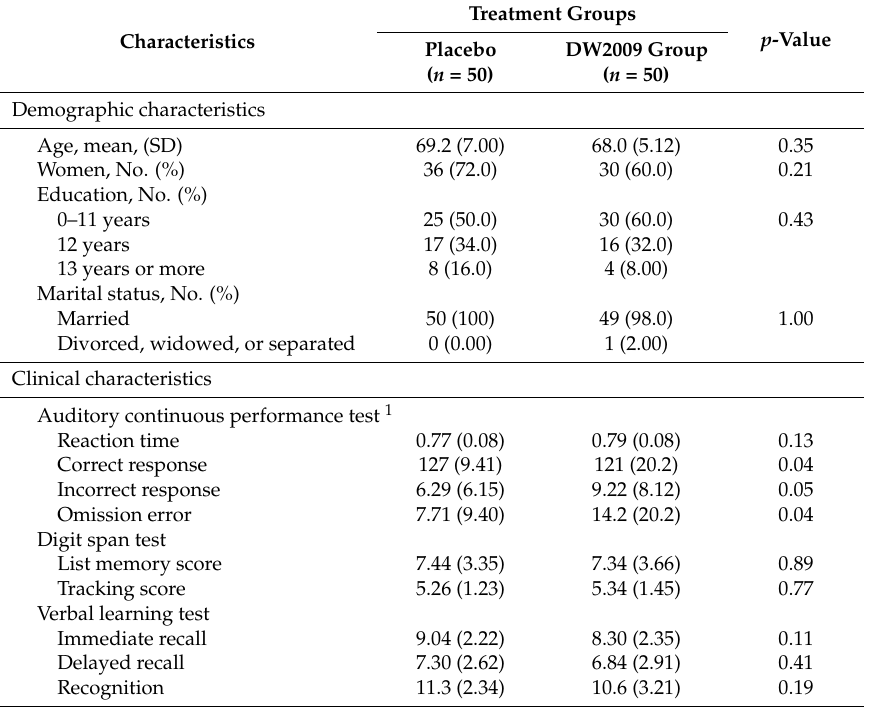
Table 1. Baseline demographic and clinical characteristics of study participants ( n =